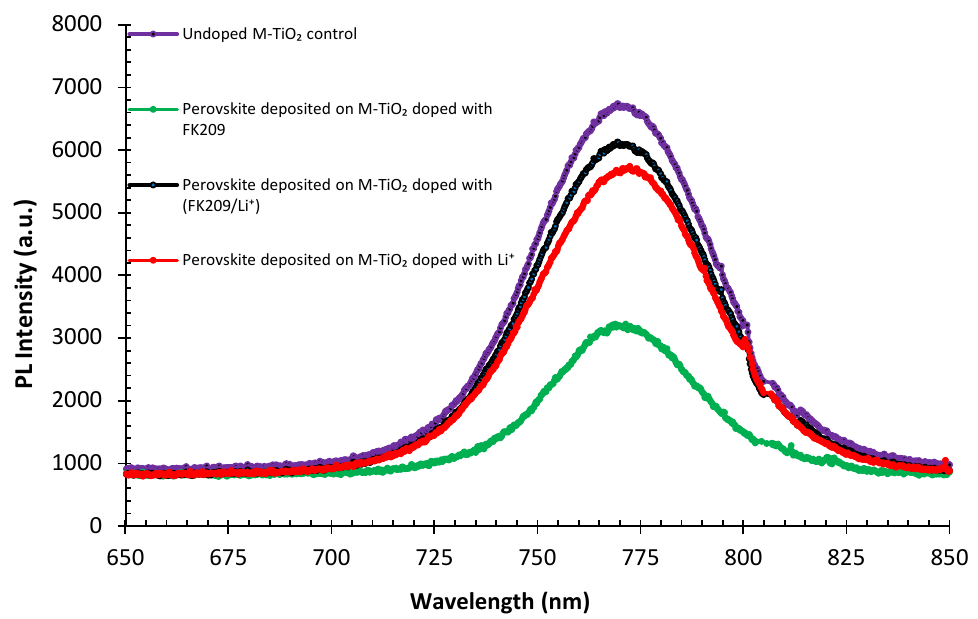
Figure 8. Photoluminescence spectra of perovskite films deposited on M-TiO 2 doped with FK209, FK209/Li + and lithium.